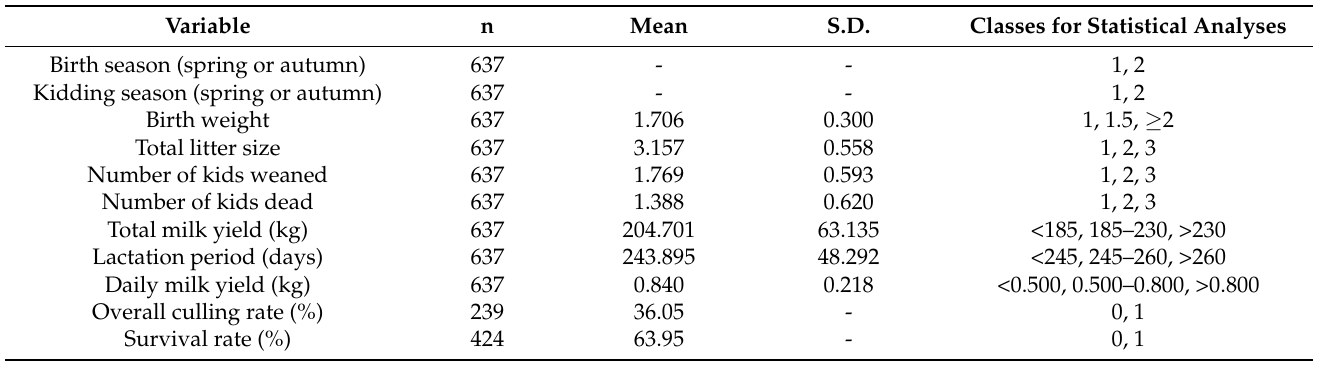
Table 1. Description of variables used to study the risk factors for culling rate in primiparous dairy Zaraibi goats.